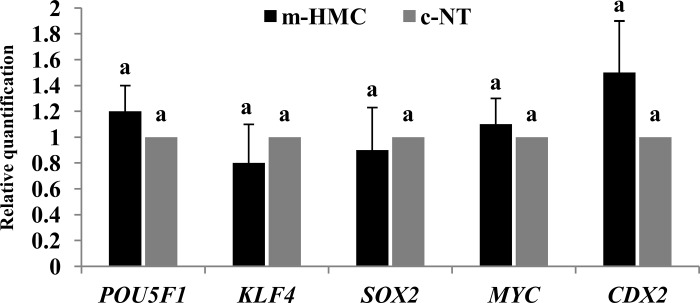
Effect of SCNT method on blastocyst gene expression.Expressions prolife of 5 developmentally important genes (POU5F1, KLF4, SOX2, MYC, and CDX2) were compared between blastocysts produced by m-HMC and c-NT methods. Different letters indicate significant differences (P<0.05).